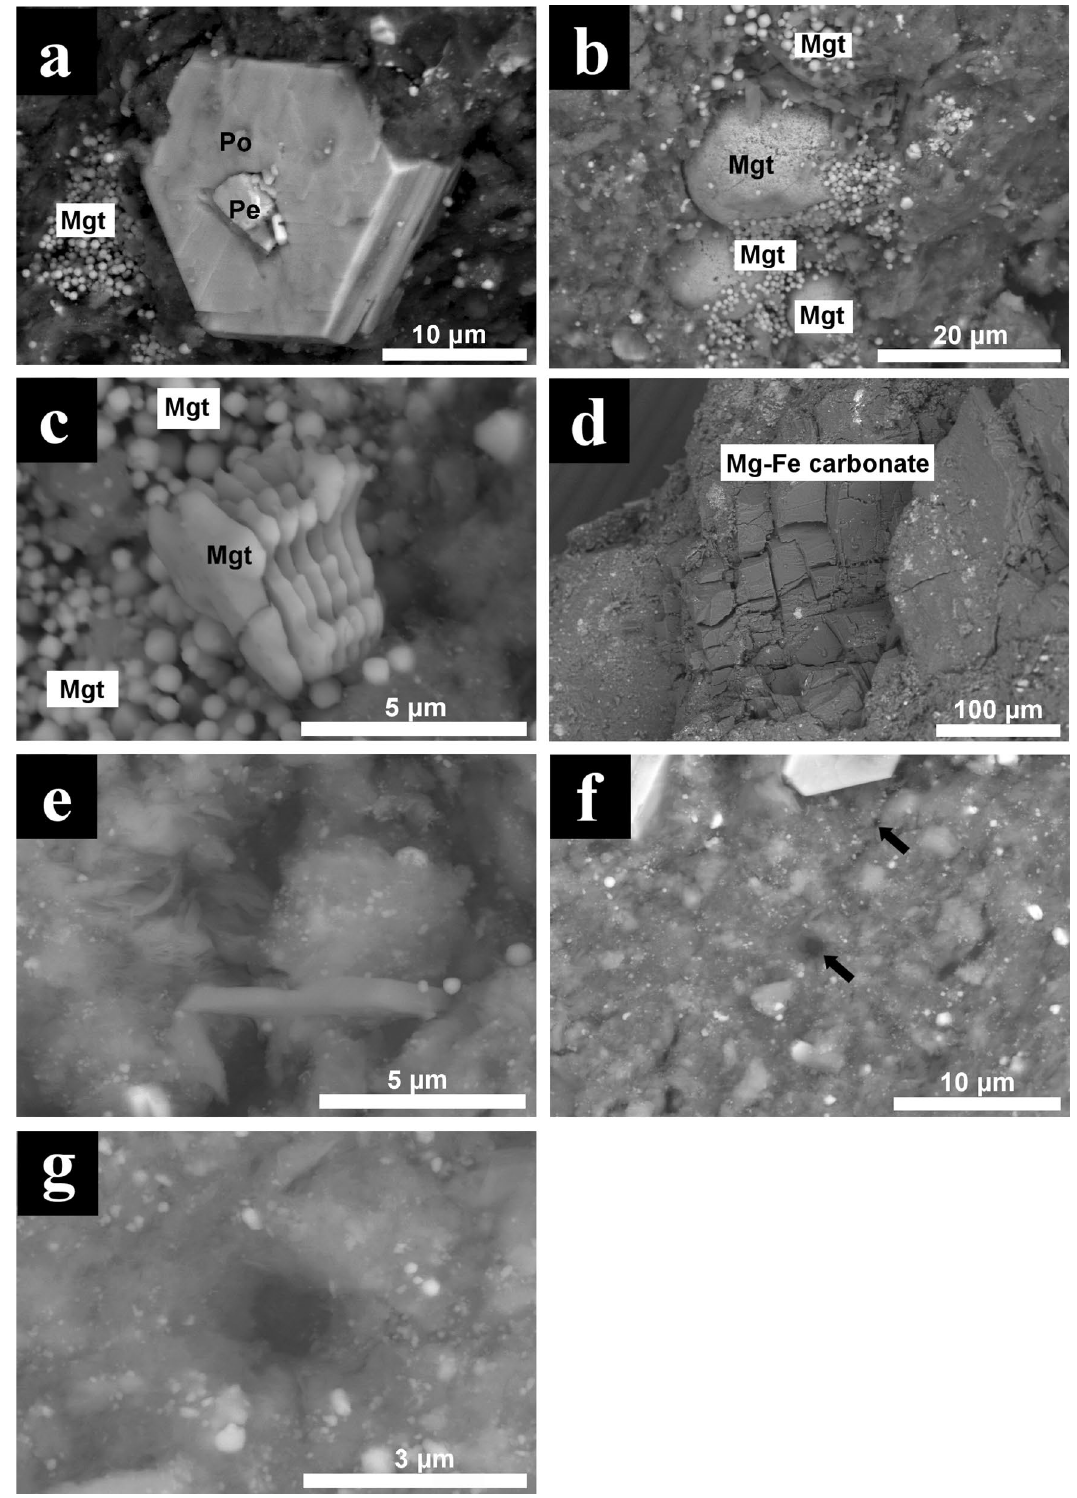
Fig. 8 Back‑scattered electron images of major constituent phases in C0041, white group. a Euhedral hexagonal morphology of pyrrhotite showing a smooth texture. b Framboidal magnetite. c Plaquette magnetite. d Large Mg–Fe carbonate. e Coarse‑grained phyllosilicate. f Circular structure‑enriched region. Larger ones are indicated by arrows. g High‑resolution image of a circular